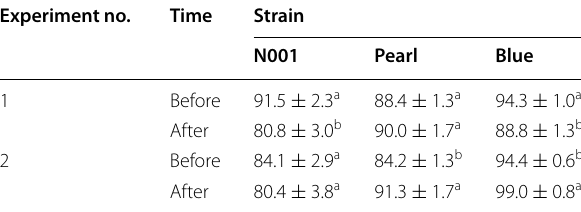
Values represent the mean standard error. Values not followed by the ± same letter within columns of the same experiment are significantly different ( p < 0.05) by Tukey’s HSD